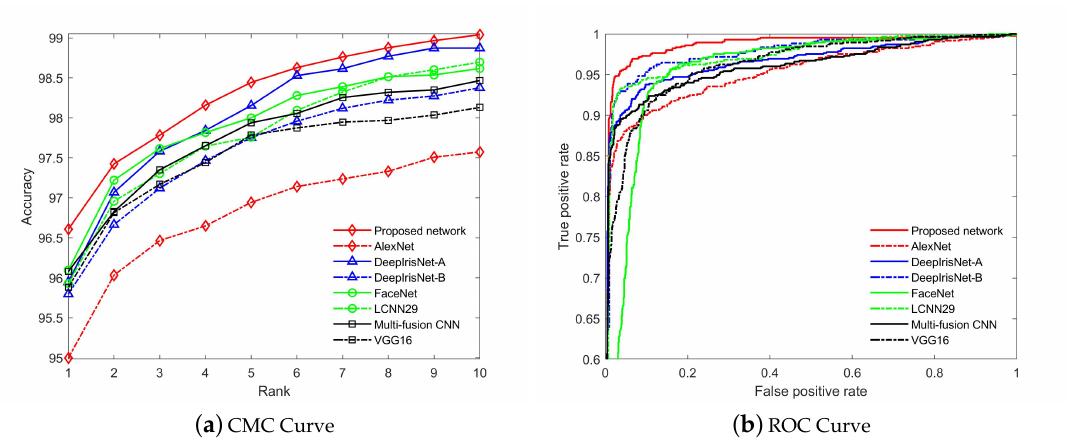
Figure 6. Performances of recognition and verification tasks on CASIA-iris distance database. The figures are the best to view in colour.